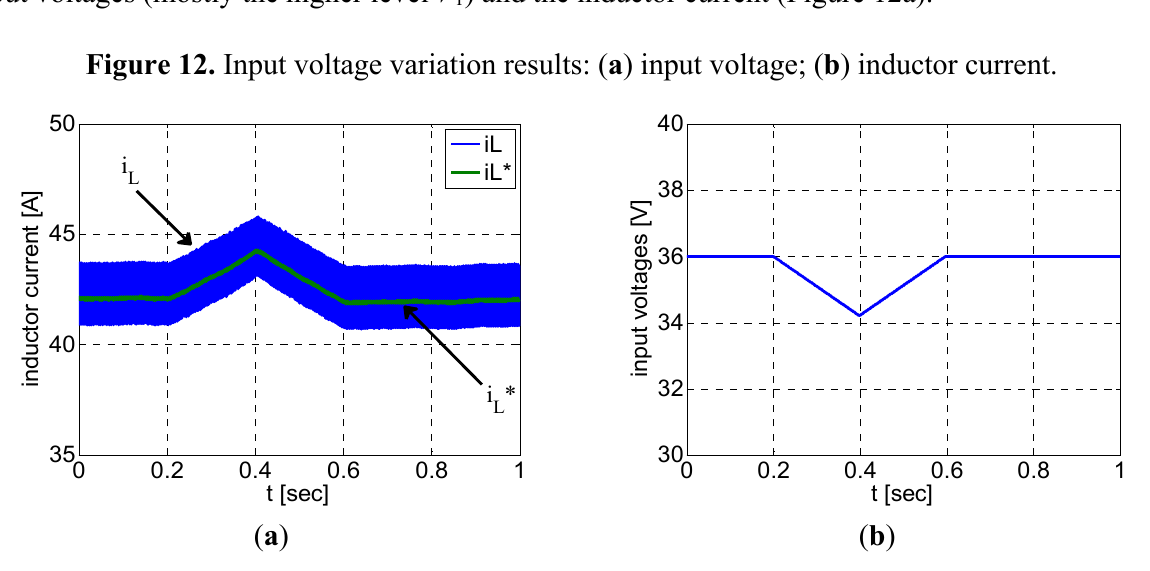
Figure 13. Input voltage variation results: ( a ) higher output voltage; ( b ) lower output